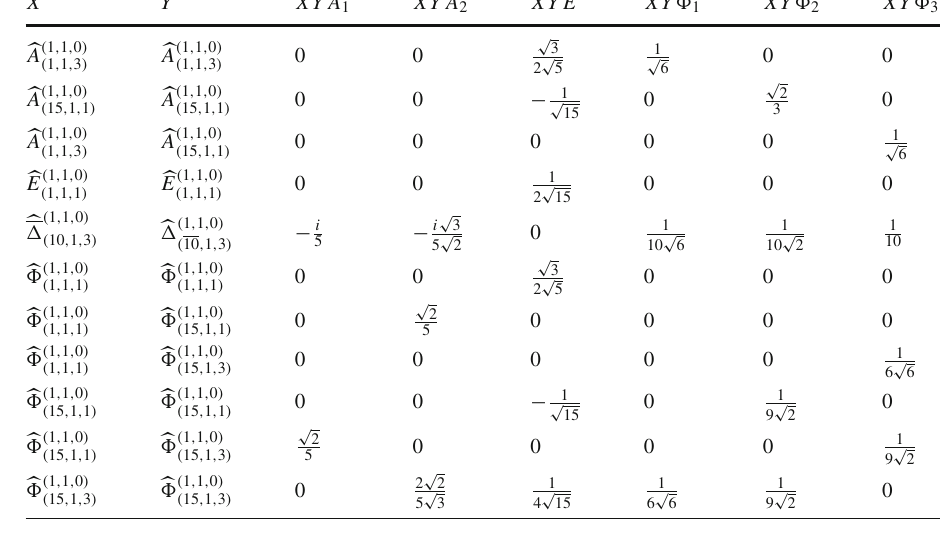
Table 3 CGCs for the Goldstones (1, 1, 1) + c.c. of G 422 SSB. Here, for